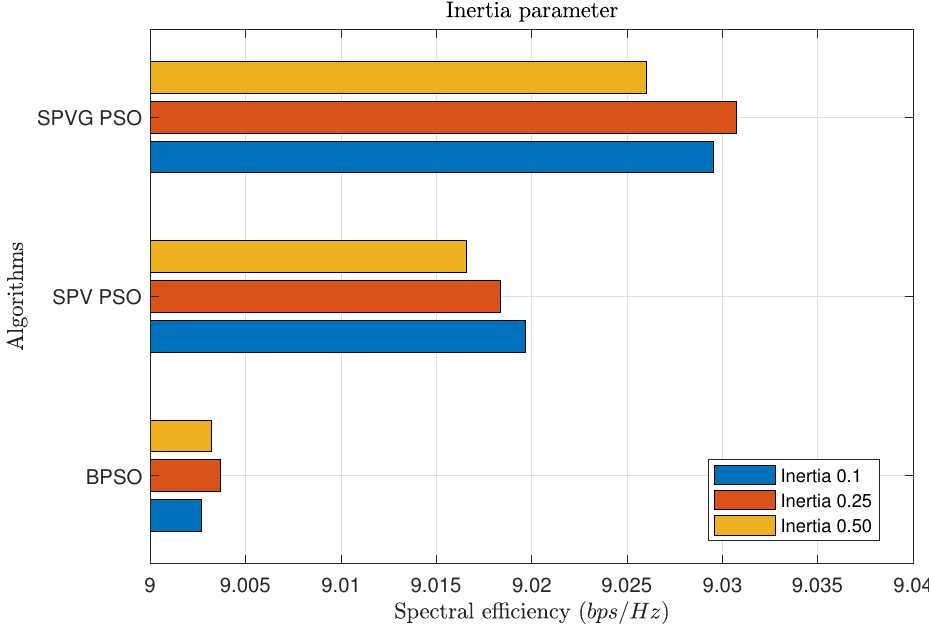
Figure 4. Results of tests to find the better parameter to inertia ( K = 20, R = 1000 m and v max = 1).